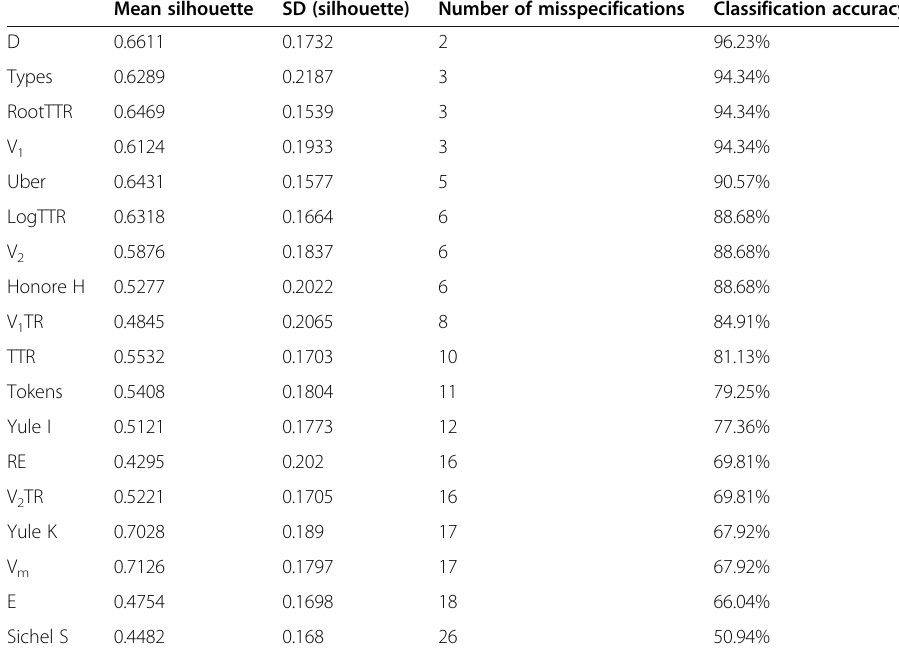
Table 5 Classification performance of the LR measures selected in the study Mean silhouette SD (silhouette) Number of misspecifications Classification